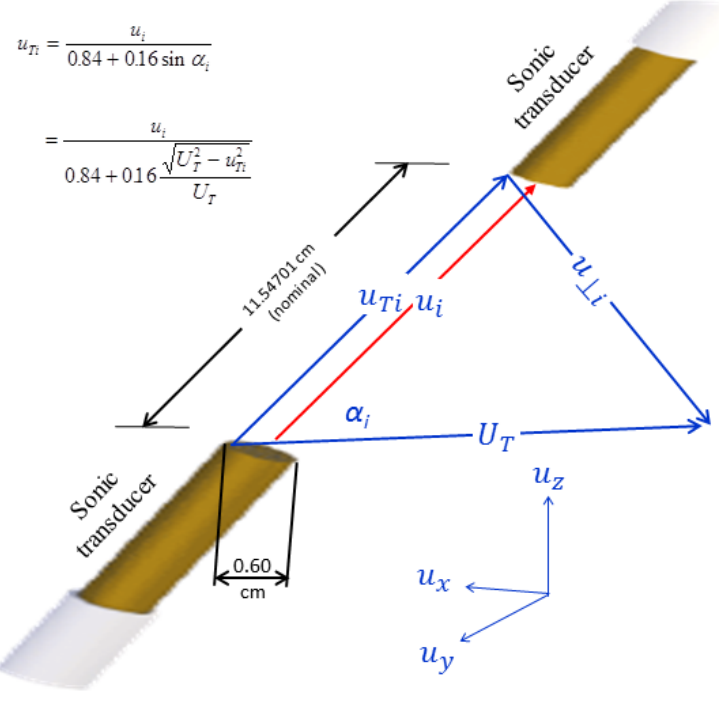
Figure 4. Sonic transducer shadowing along the i th ( i = 1, 2, or 3) sonic path between the two sonic transducers, u i is the measured magnitude of flow vector whose true magnitude is u Ti ; u ⊥ i is the flow speed normal to the i th sonic path; u x , u y , and u z are the wind speeds expressed in the three-dimensional orthogonal anemometer coordinate system; and α i is the angle between sonic path i and the total flow q q + u 2 u 2 u 2 x + u 2 y + u 2 z . See Wyngaard and Zhang (1985) and Kaimal and Finnigan (1994) for the equation to vector ( U T ) equal to ⊥ i or i calculate u Ti